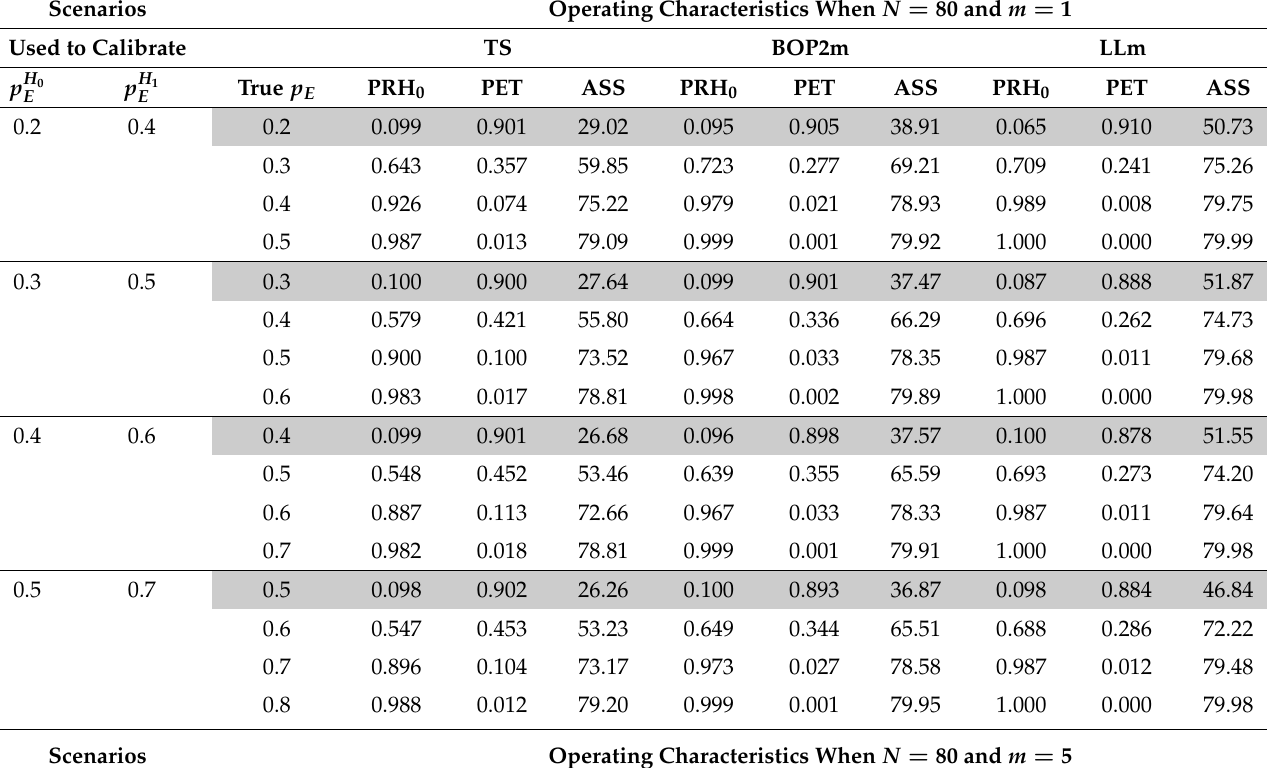
Table 5. Operating characteristics of the TS, BOP2m and LLm designs, when N min = 10, δ = 0.1, N = 80 and the type I error rate is controlled at the level 0.1. The lines in gray represent the operating characteristics under the null